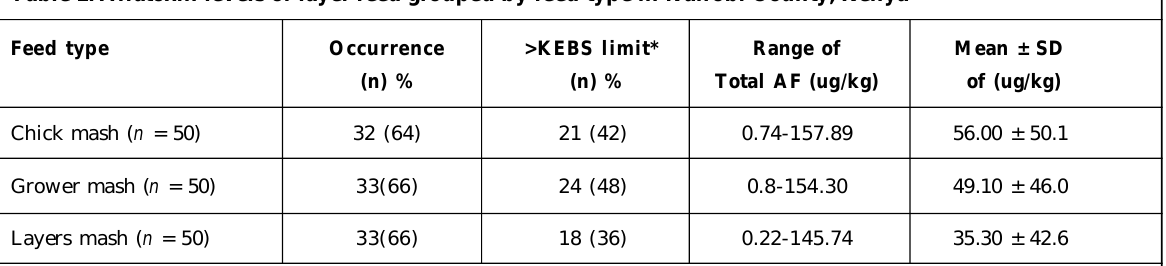
Table 2: Aflatoxin levels of layer feed grouped by feed type in Nairobi County, Kenya Feed type Occurrence >KEBS limit* Range of Mean ± SD